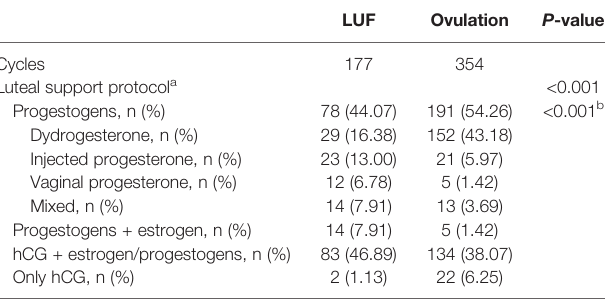
TABLE 2 | Luteal support protocols of LUF group and ovulation